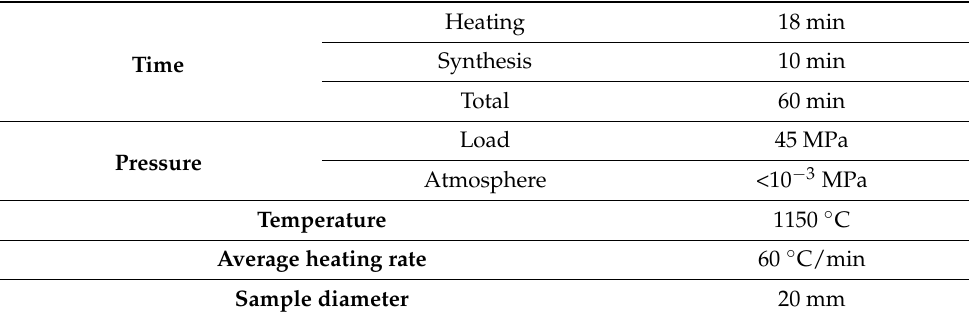
Table 3. Process parameters of Inconel 625-NbC Spark Plasma